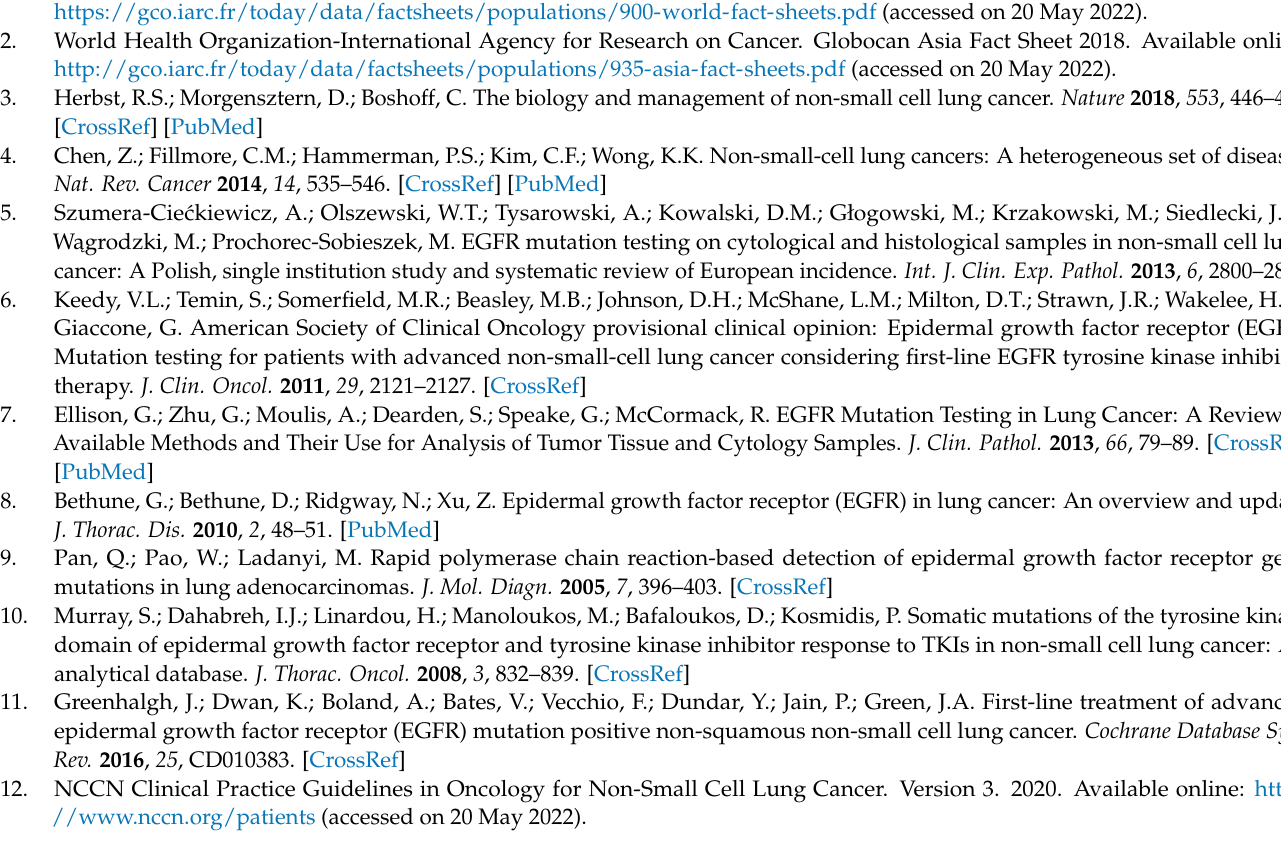
stratified by the generation of treatment regimens. (B) Pooled hazard ratios (95% confidence intervals) for overall survival and progression-free survival stratified by the reversibility of the treatment regimens; Figure S4: Pooled estimates of the exploratory analyses for adverse events of grade ≥ 3; Figure S5: Toxicity profile in relation to the incidence (%) of each specific adverse event (any grade) based on the overall population of each treatment included in the network meta-analysis; Figure S6: Pooled estimates of the network meta-analysis in the first sensitivity analysis by Bayesian approach; Figure S7: Convergence of the three chains established by inspection of the history feature and the Brooks–Gelman–Rubin diagnostic for (A) overall survival, (B) progression-free survival, and (C) adverse events of grade ≥ 3; Figure S8: Pooled estimates of the network meta-analysis after including only phase III trials in the second sensitivity analysis; Figure S9: Pooled estimates of the network meta-analysis after excluding FLAURA studies in the third sensitivity